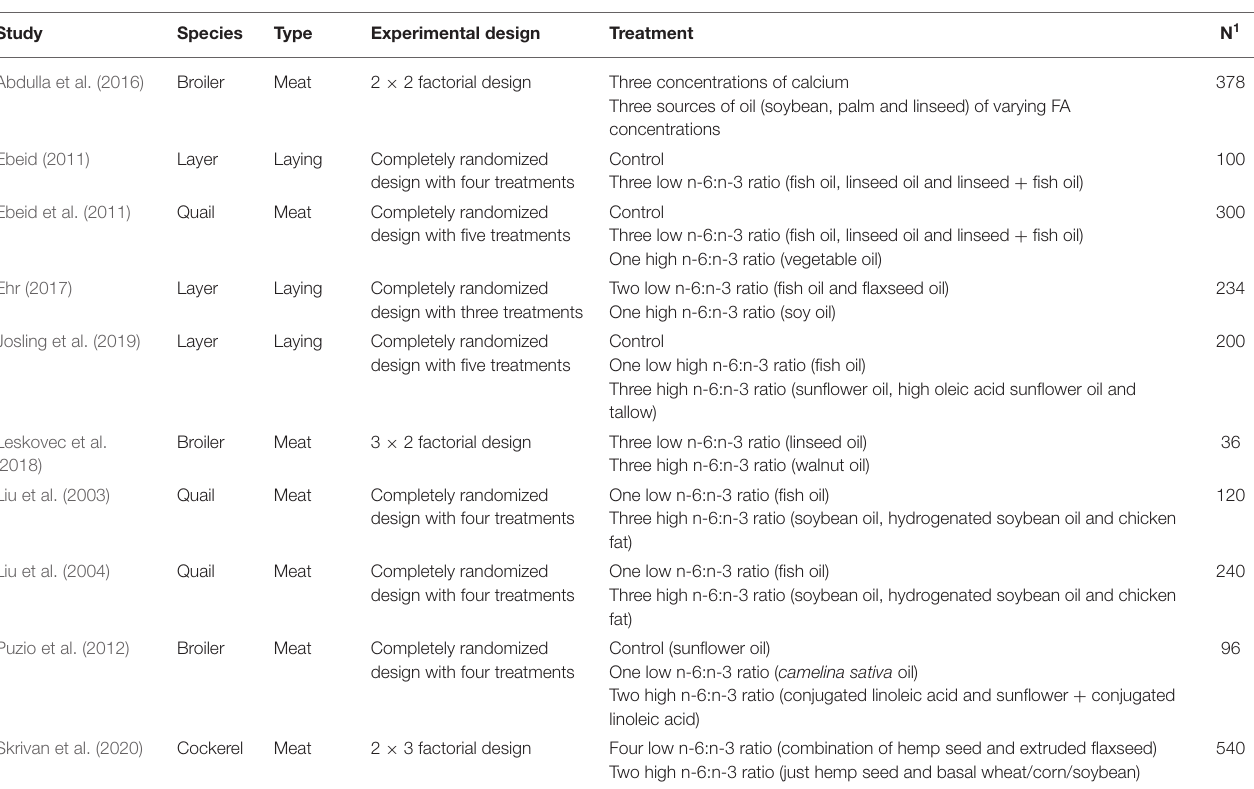
TABLE 1 | Summary of studies included in the direct feeding influence